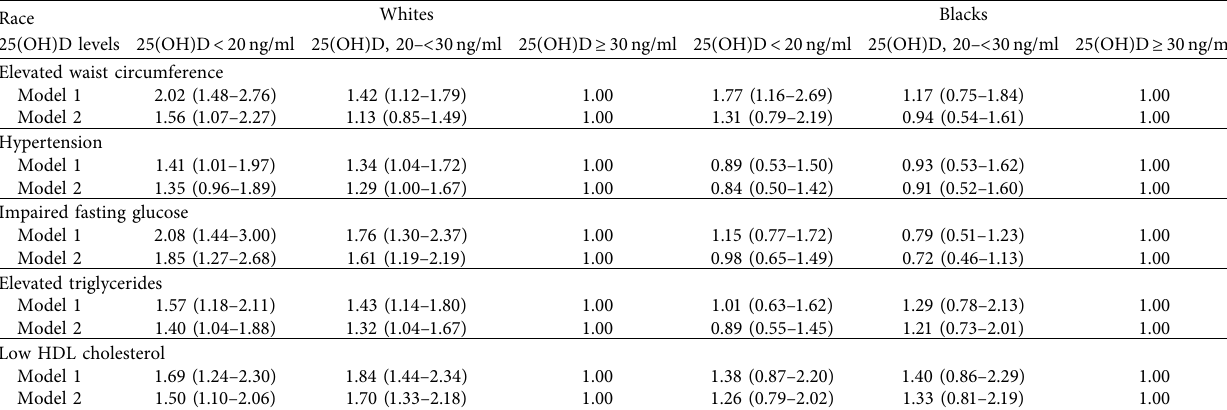
Table 3: Association between 25-hydroxyvitamin D levels and MetS components at baseline in the Health ABC cohort by race. Race